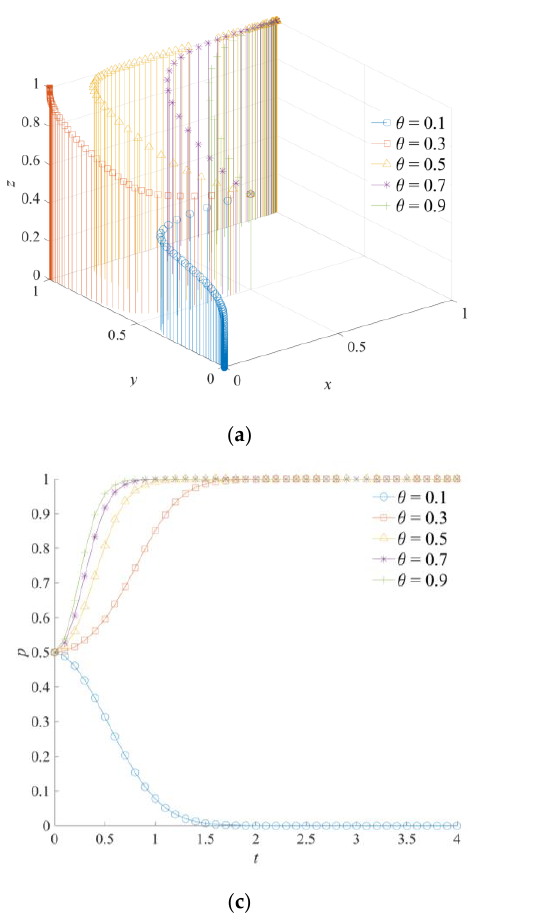
Figure 5. Evolution trajectory of the game system under different effective coefficients of national–local government emergency dispatching: ( a ) The influence of θ on the evolution of the game system; ( b ) the influence of θ on the evolution of the local government; ( c ) the influence of θ on the evolution of the neighboring government; ( d ) the influence of θ on the evolution of the central government.